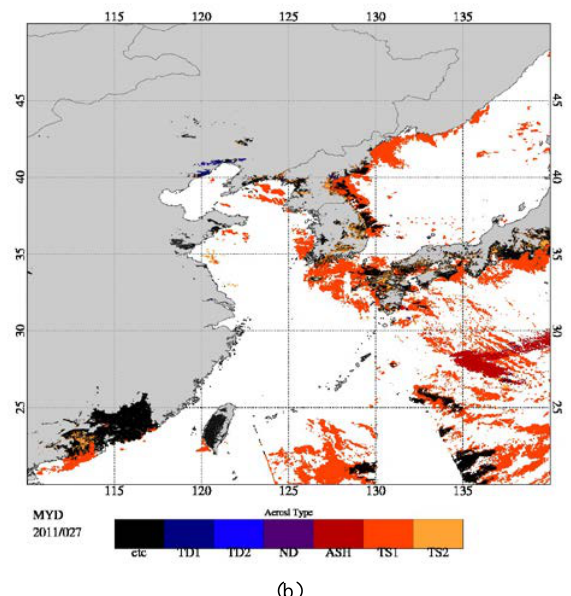
Figure 6. (a) Terra and (b) Aqua MODIS volcanic ash plume identified by using the VA detection algorithm for the Shinmoedake volcanic eruption on 27 January 2011. The color composite RGB image (top) and aerosol type detection results (down). Colors and abbreviation denote dust (TD1, TD2), non- dust(ND), volcanic ash(ASH), and smoke (TS1, TS2), respectively.